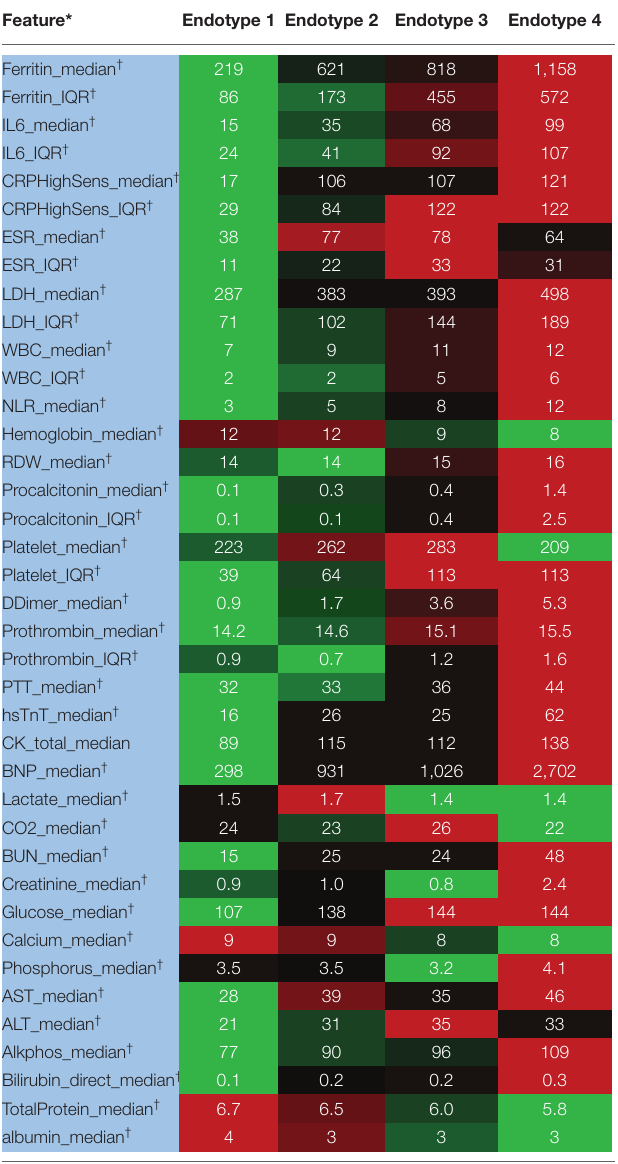
* Values are color-coded for each feature from red (high) to black (median) to green (low). Full set of features can be found in Supplementary Material 5 . † Denotes p < 0.001. a mortality of 21%, had the longest hospital length-of-stay (median: 41 days), and had the second-highest prevalence of intubation (72%). Patients in this endotype had a relatively low number of comorbidities. Endotype 3 patients had similar inflammatory markers as endotype 2 (ferritin, CRP, ESR, and LDH, but not IL-6 which was significantly higher), second- highest infectious markers (WBC and procalcitonin, although procalcitonin was not significantly > endotype 2), and second- highest coagulopathy markers (PT and PTT, but PT was not significantly < endotype 4). Endotype 3 patients received